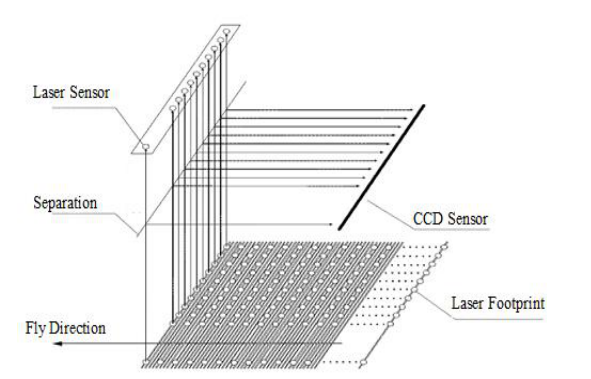
Figure 2. Common optical path payload imaging principle